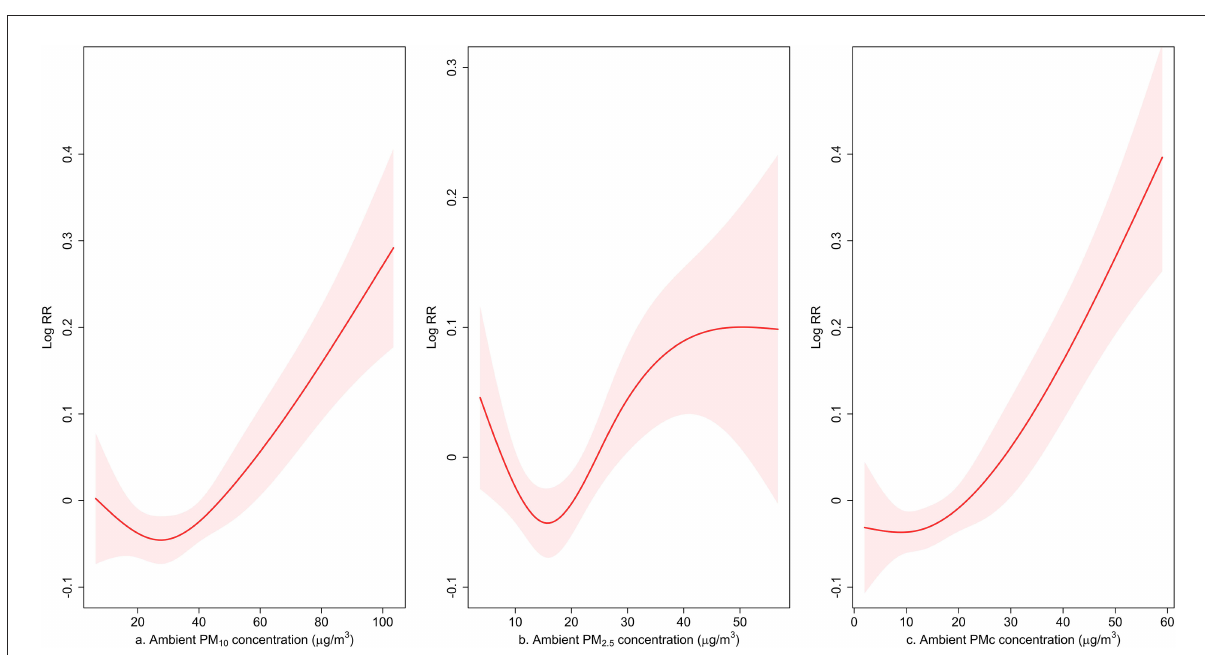
FIGURE2 Exposure–response curve for the association between PM 10 , PM 2.5 , and PMc (lag03) and the number of outpatient visits to fever clinics. The line represents the point estimates and the shading indicates corresponding 95% CIs, which were derived from an over-dispersed generalized additive model, with weather conditions, day of the week (DOW), and public holiday (PH) controlled.